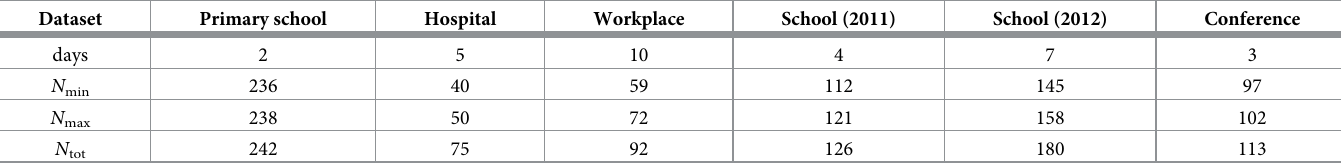
Table 1. Information about the datasets. or each dataset, we present the observation period in terms of the number of days, the minimum and maximum numbers of nodes in the daily partition of the dataset ( N min and N max ), and the number of distinct nodes in the entire dataset ( N tot ), respectively.